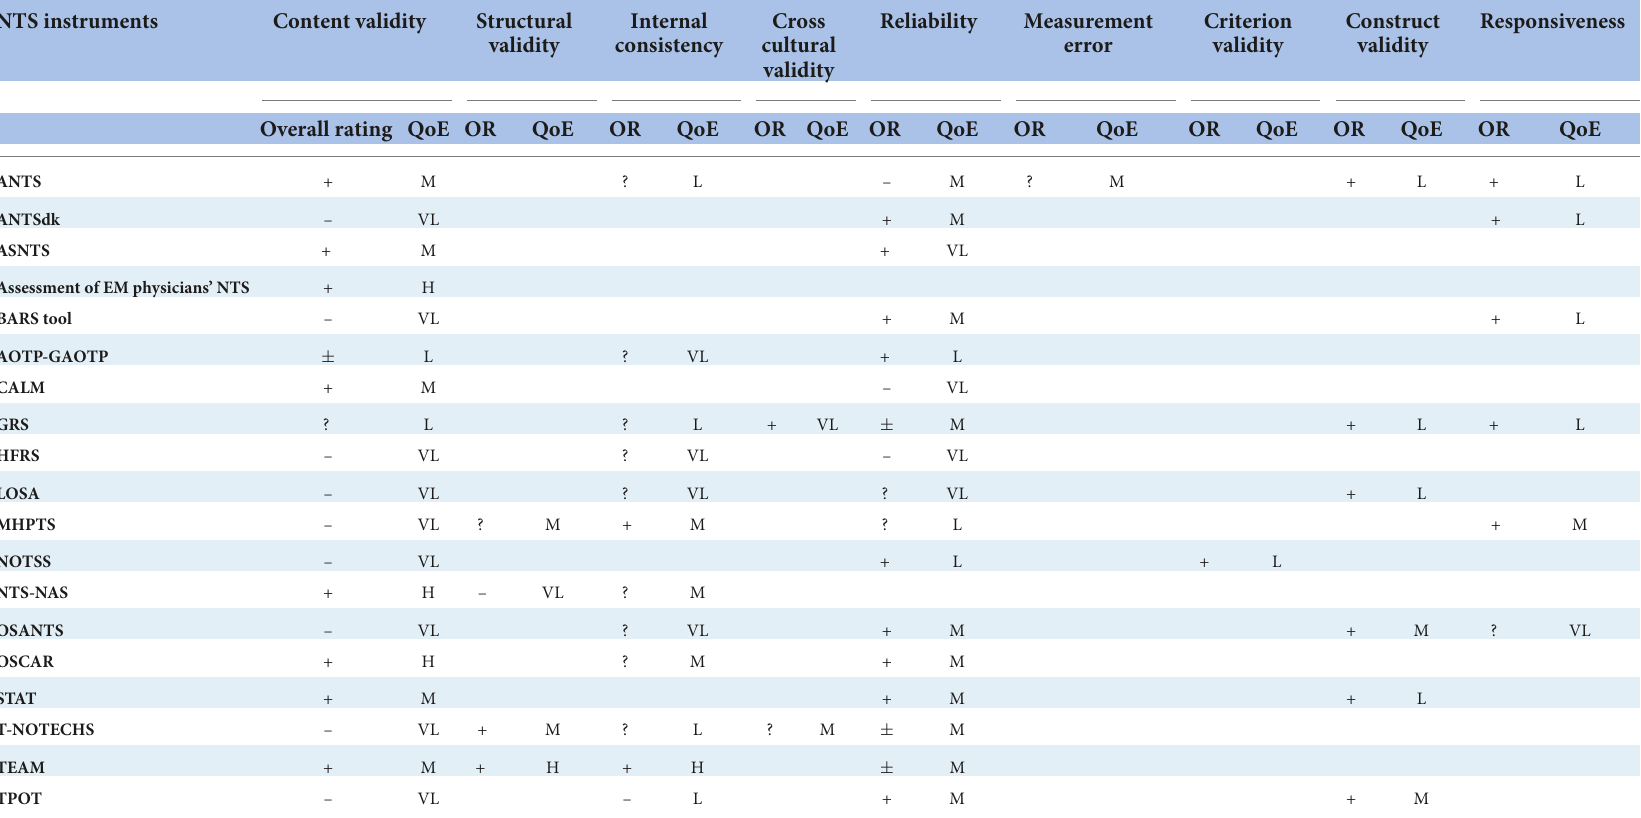
TABLE 3 Evaluation of the measurement properties and quality grading of the evidence of NTS